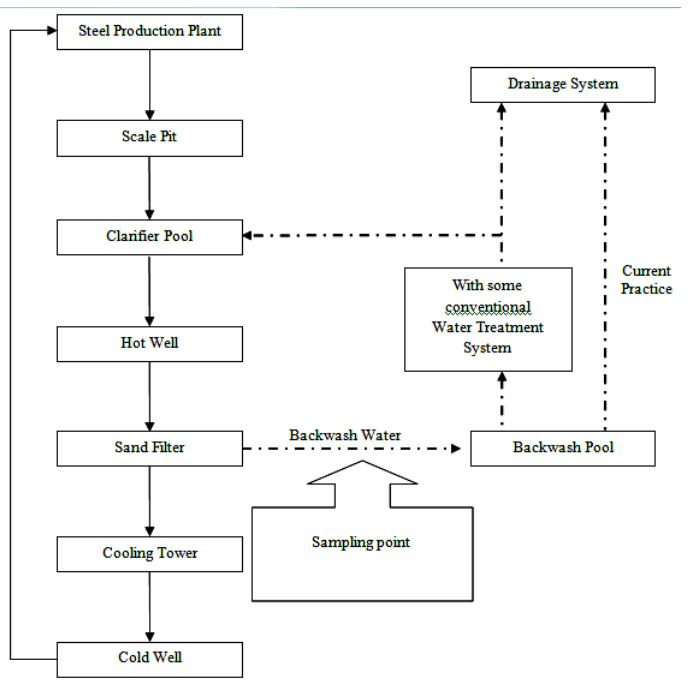
Figure 1. Point of sampling of the